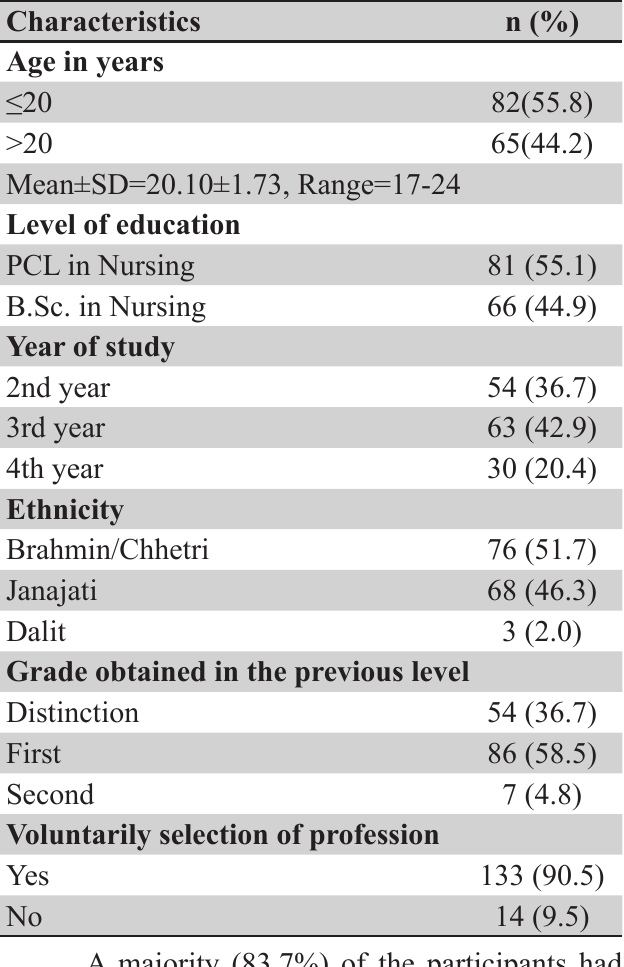
Table 1. Participants’ Demographic Profiles (N=147). Characteristics